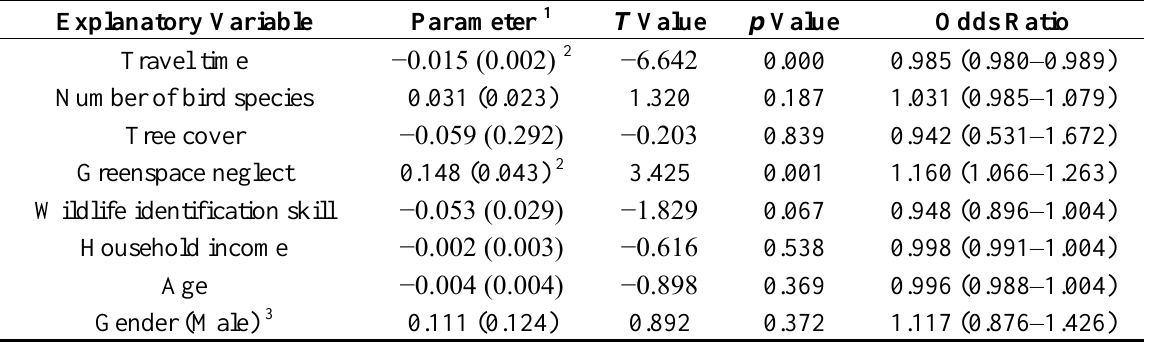
Table 3. Ordered logistic regression exploring the relationship between visit frequency, of the respondent and their ability to identify